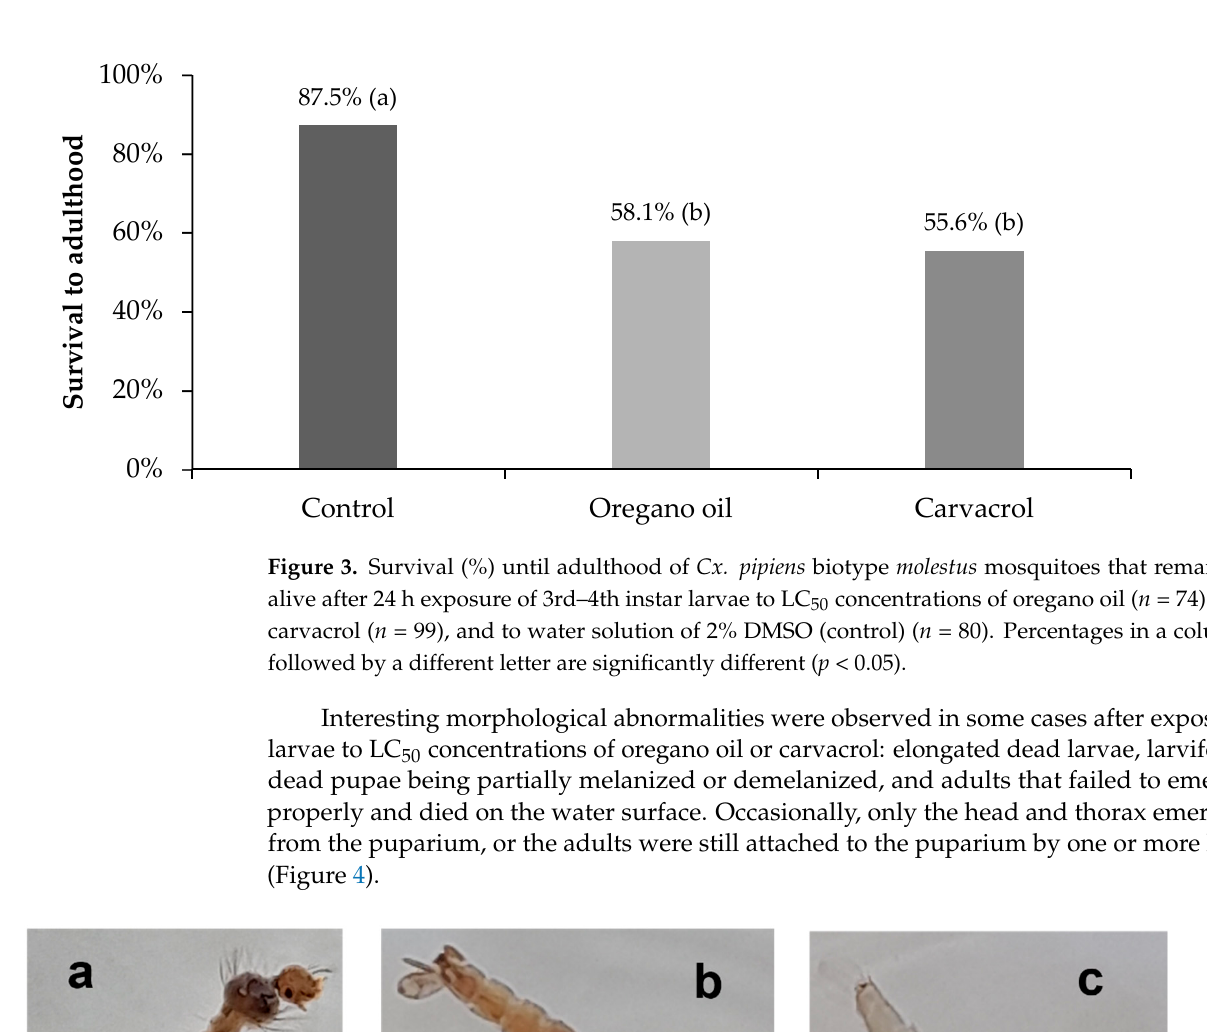
Figure 2. Pupal survival (%) of Cx. pipiens biotype molestus mosquitoes that remained alive after 24 h exposure of 3rd–4th instar larvae to LC 50 concentrations of oregano oil ( n = 55) and carvacrol ( n = 69), and to water solution of 2% DMSO (control) ( n = 71). Percentages in a column followed by a